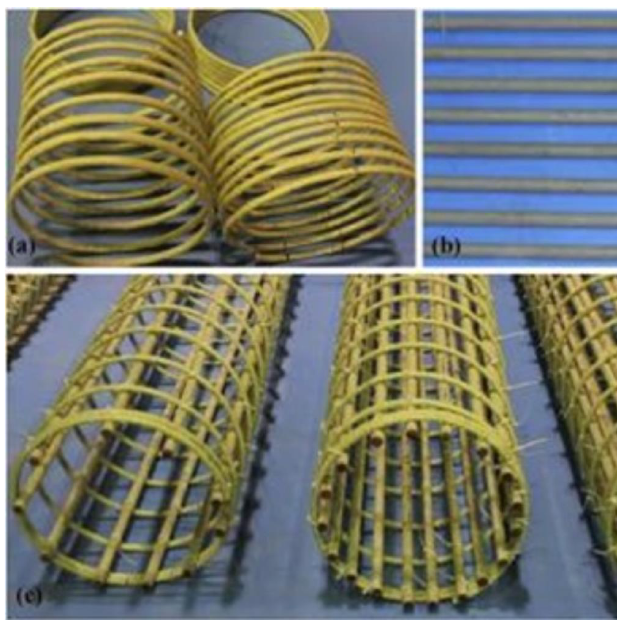
Figure 1. GFRP reinforcements; ( a ) transverse spirals, ( b ) longitudinal bars, and ( c ) GFRP cage. Table 1. Characteristics of GFRP and steel